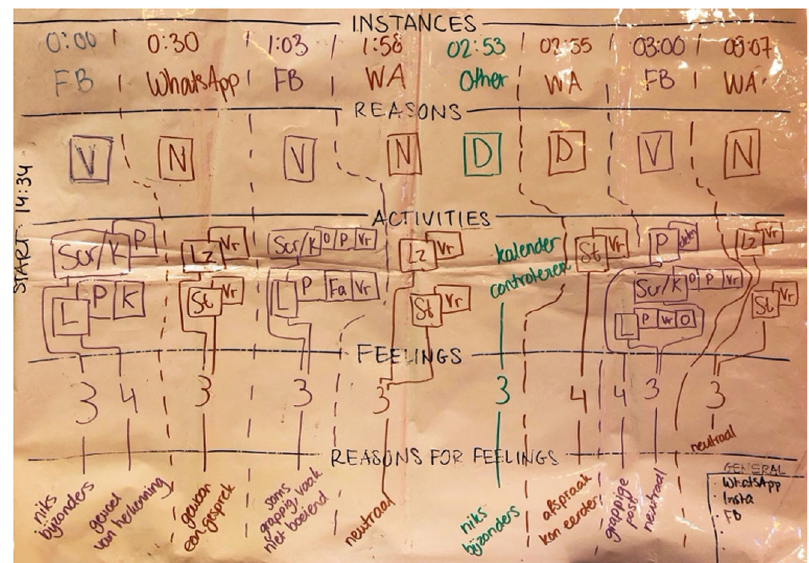
Fig. 1 Stimulated recall chart. An example of a fi lled-out stimulated recall chart. Rows indicate (from top to bottom): timestamp start and app/activity, motivation abbreviation (Dutch), speci fi c activity and related social ties attached to top right, feeling score, and feeling elaboration